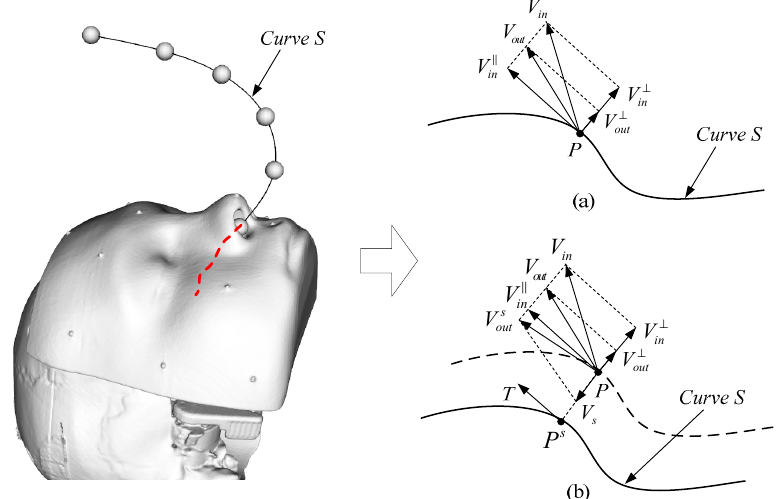
Figure 2. Schematic diagram of GVF based on the spatial curve ( a ) The robot end is on the guiding curve, ( b ) the robot end is not on the guiding